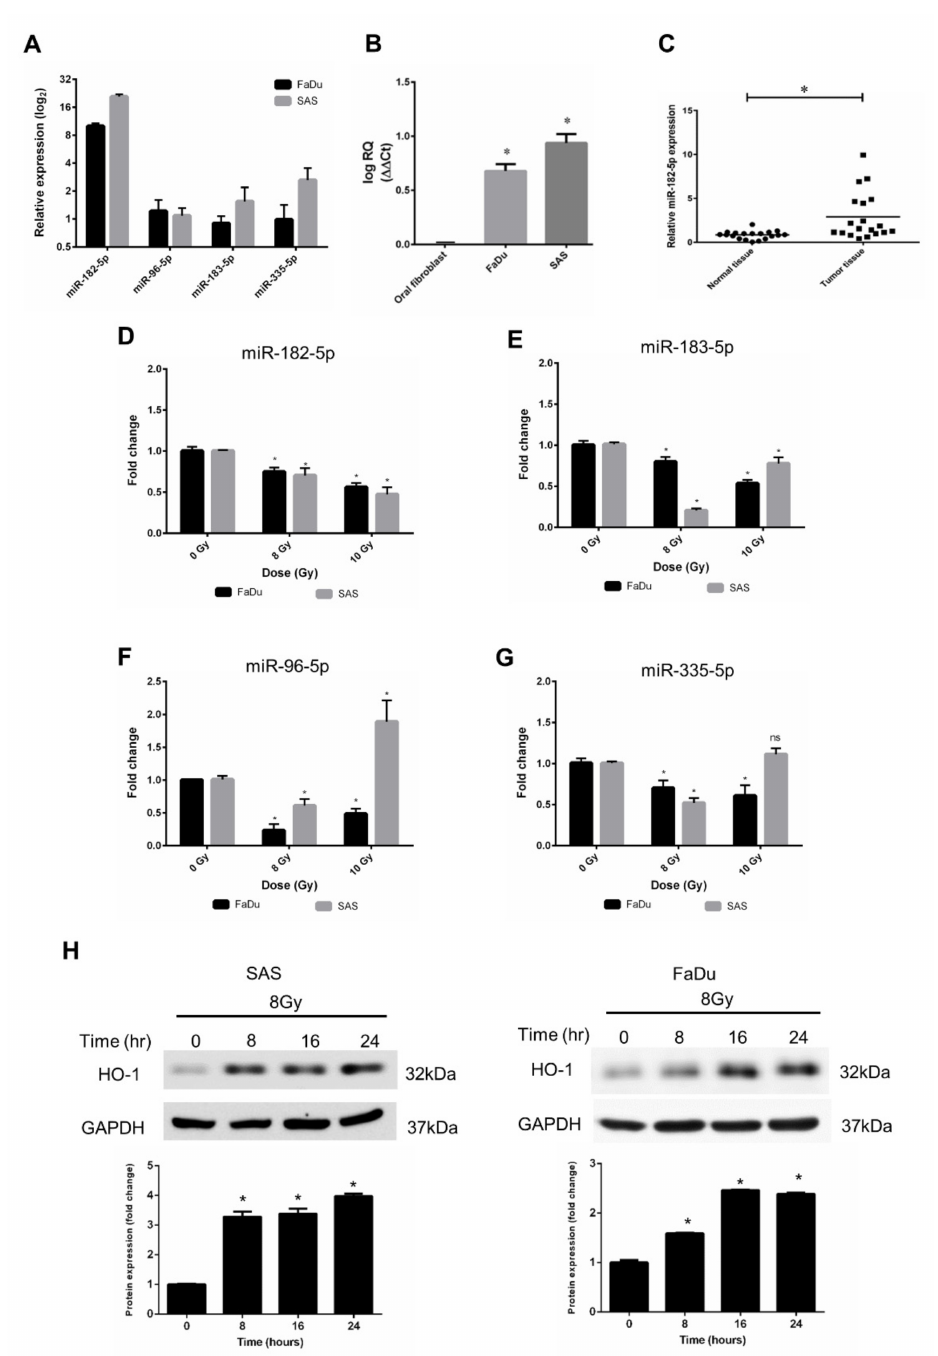
Figure 3. Effects of radiation on the expression of the miR-182/96/183 cluster in HNSCC cells. ( A ) Comparison of endogenous miR-182, miR-96, miR-183, and miR-335 expression in FaDu cells and SAS cells using qPCR analysis. ( B ) Comparison of the endogenous expression of miR-182-5p in normal oral fibroblasts and HNSCC cells. ( C ) Use of surgically excised clinical samples to compare